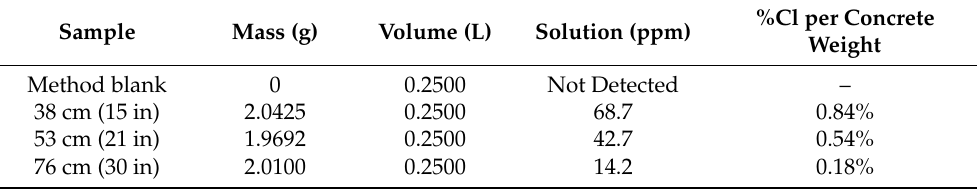
Table 6. Percentage of chloride content per weight of concrete (2nd